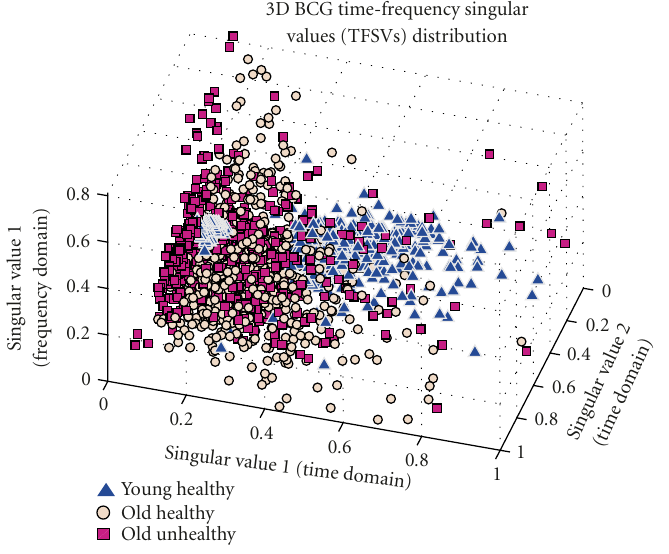
Figure 5: A 3D scattergram for TFM-SV features of all extracted BCG cycles of six subjects under test (two young normal, two old normal, and two old abnormal subjects). Only the first three features of the TFM-SVD algorithm are normalized to [0,1] and shown in this 3D